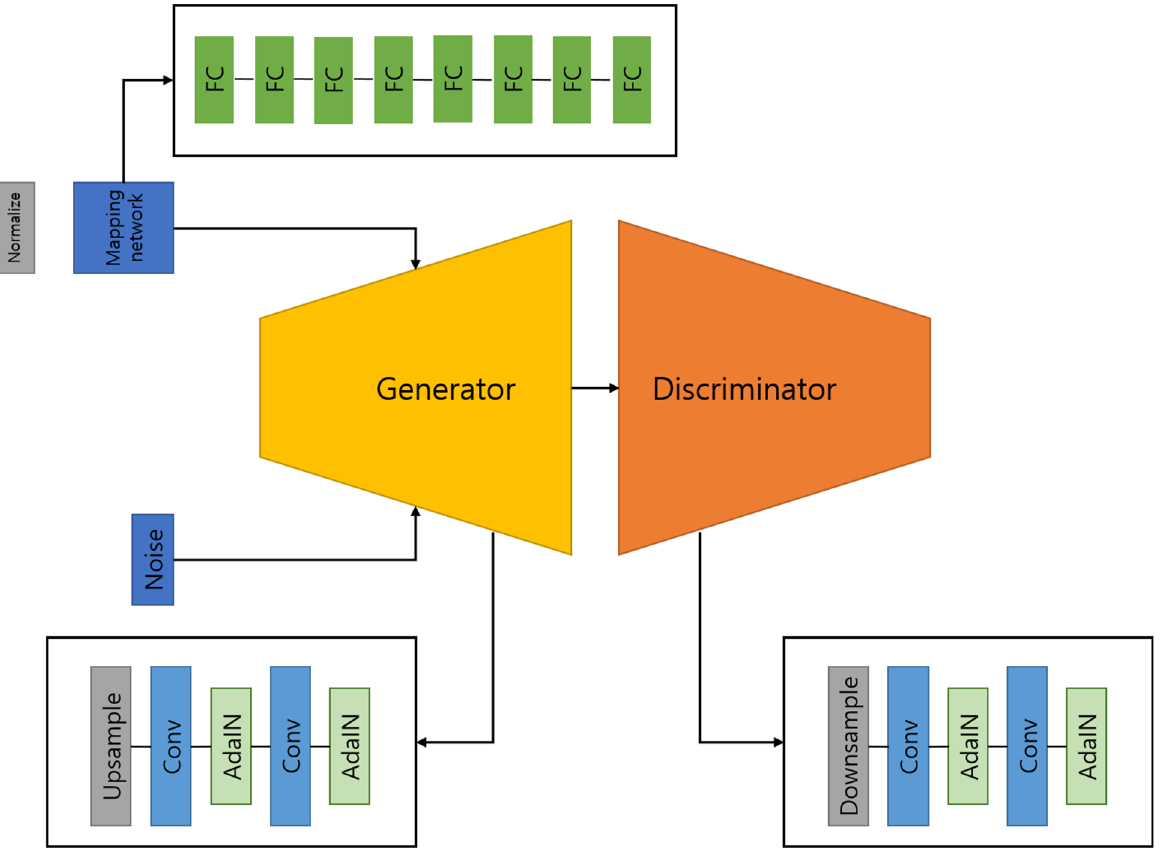
Figure 6. Structure of GAN module that performs hairstyle conversion.